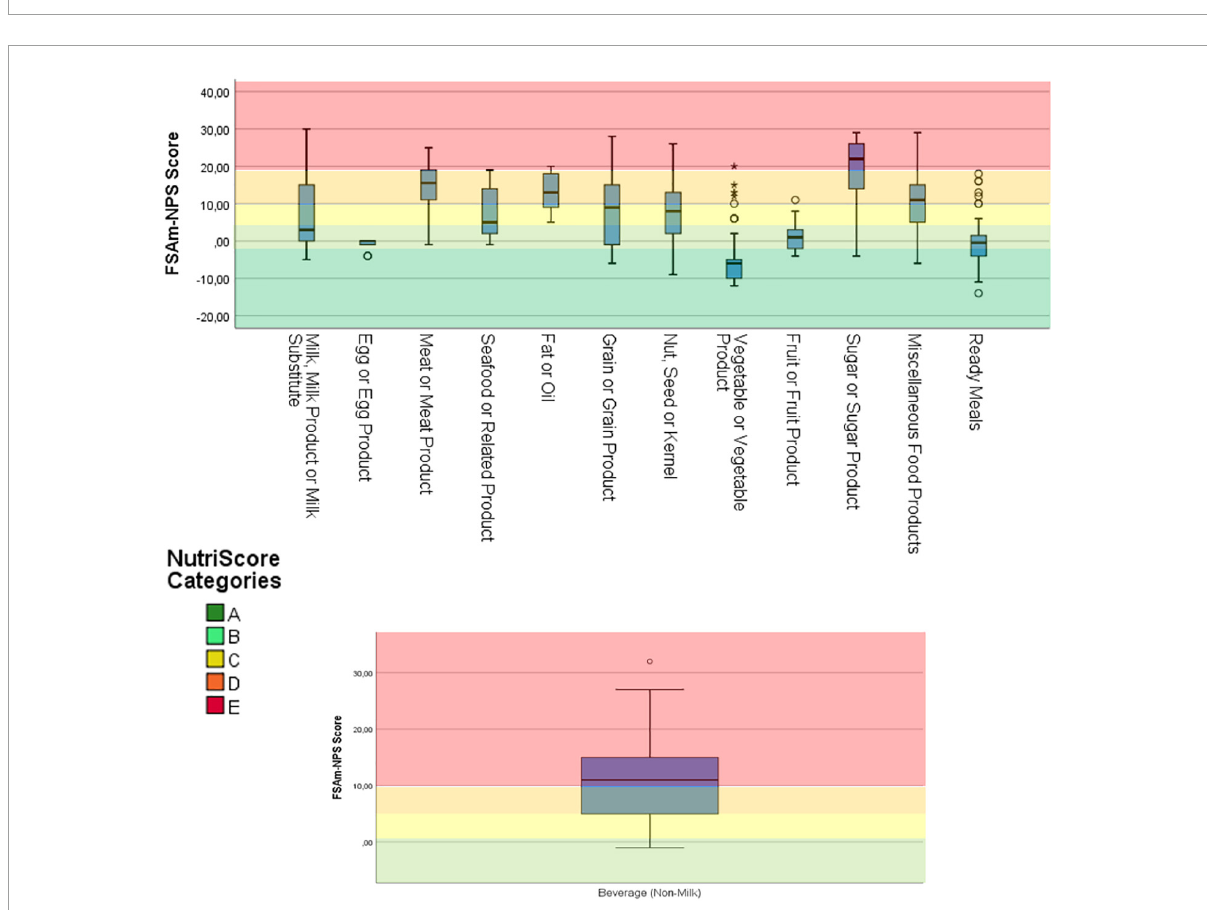
FIGURE2 Overall distribution of products within the main food categories. Dark green: Nutri-Score “A”, light green: Nutri-Score “B”, yellow: Nutri-Score “C”, light orange: Nutri-Score “D”, and dark orange: Nutri-Score “E”. No Nutri-Score “A” was represented on the graphic of beverages, given that only waters can be classified as “A” and were thus excluded from the graphic ( n =